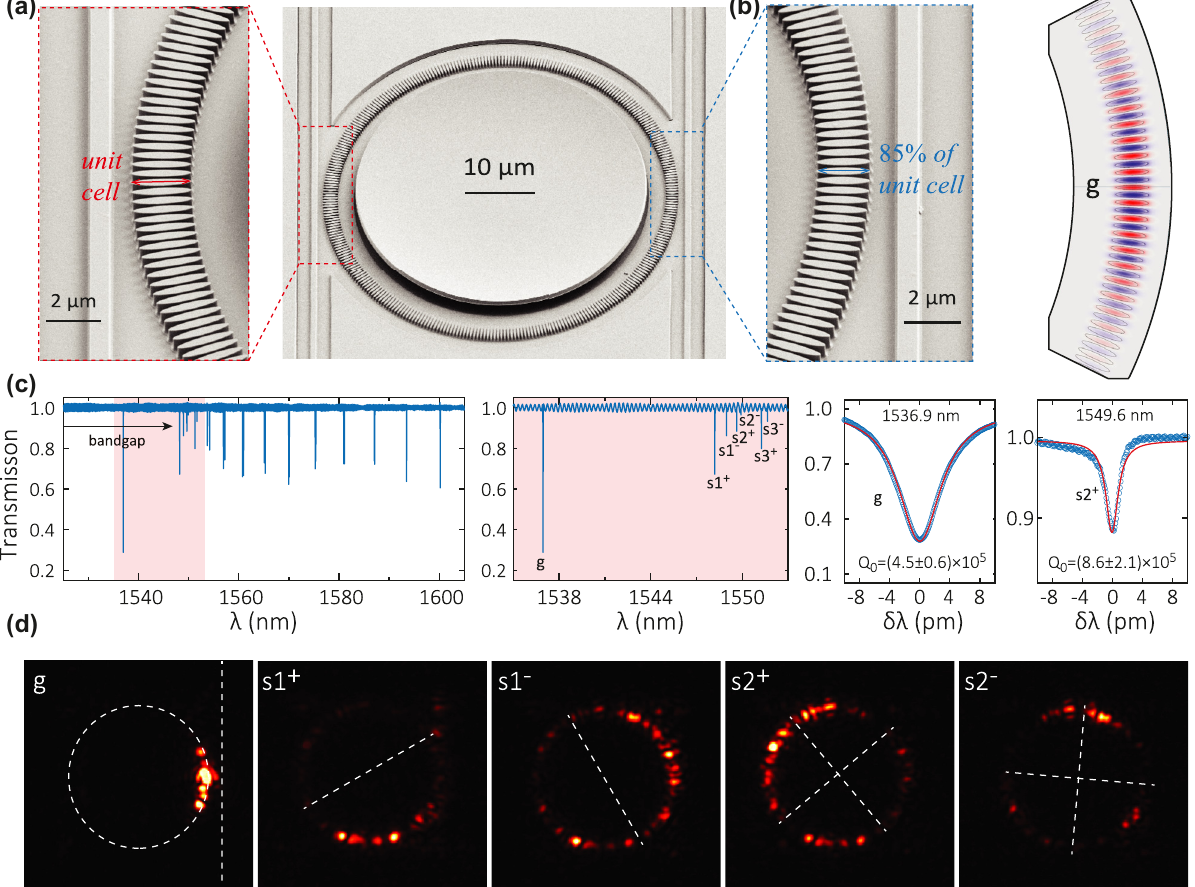
Figure 3: Implementing a defect photonic crystal cavity in the rPhCR. (a) SEM images of a rPhCR device with zoom-in views of cells in the uniform region (left) and the defect region (right). The unit cell parameters are similar to those in Figure 2, except that its outer ring radius is now R In the defect region, a scaling of the unit cell is introduced with a quadratic function across 48 cells and a maximal 15% reduction of the RW when it is closest to the waveguide. The center of the rods remains fixed in distance to the rPhCR center. (b) Simulation of the defect photonic crystal cavity mode, labeled as the g mode hereafter. The simulated mode volume is 1.5 μ m 3 , that is, 3.3 ( 𝜆 ∕ n ) 3 . The simulated Q spectrum of this defect rPhCR device measured through the waveguide adjacent to the defect, showing the g mode, dielectric band-edge modes, and the bandgap (which extends as far as the non-defect devices in Figure 2 beyond the laser scan range). A zoom-in of the modes at the dielectric band-edge (pale red and blue shaded area) is displayed in the middle panel, labeled as { g , s 1 ± , s 2 ± } . The right panels show nonlinear least squares fits to the g and s 2 + modes, respectively. The g mode has a loaded optical quality of Q uncertainty of the Q values represents the 95% confidence range of the nonlinear fitting. (d) Infrared images of the { g , s 1 ± , s 2 ± } modes. This g mode is a localization of the s 0 mode in a defect-free